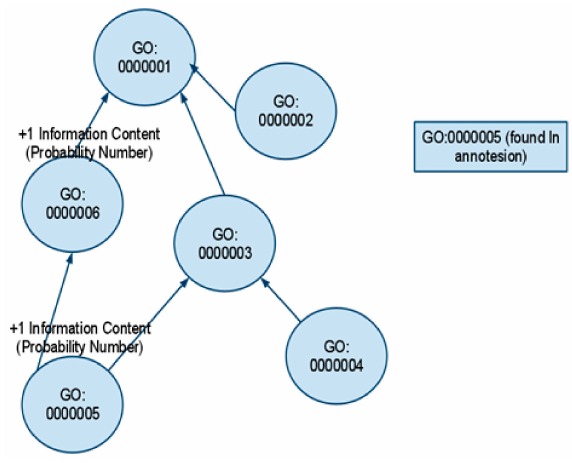
Figure 7. Gene Ontology Tree.